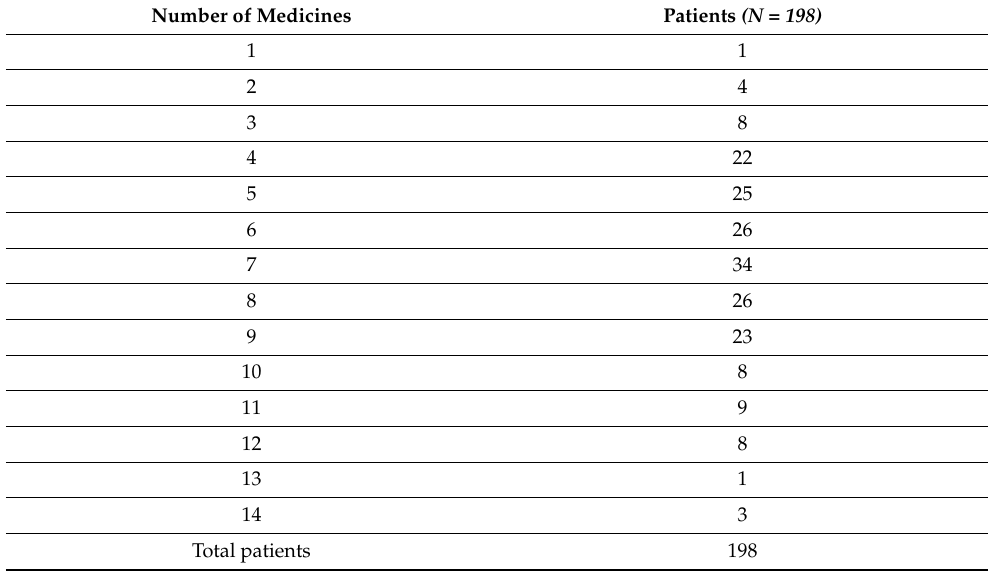
Table 1. Patients included in the study with